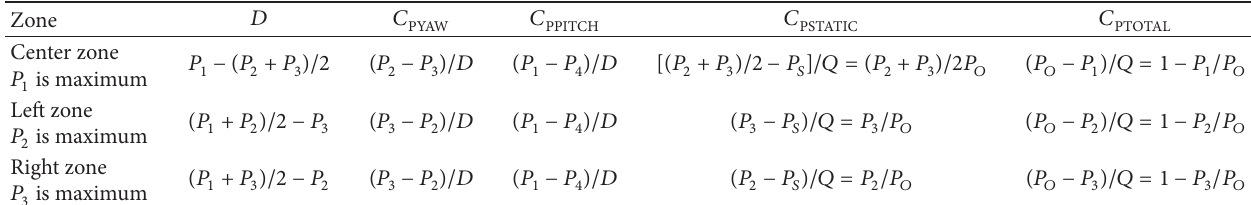
Table 1: Definition of calibration